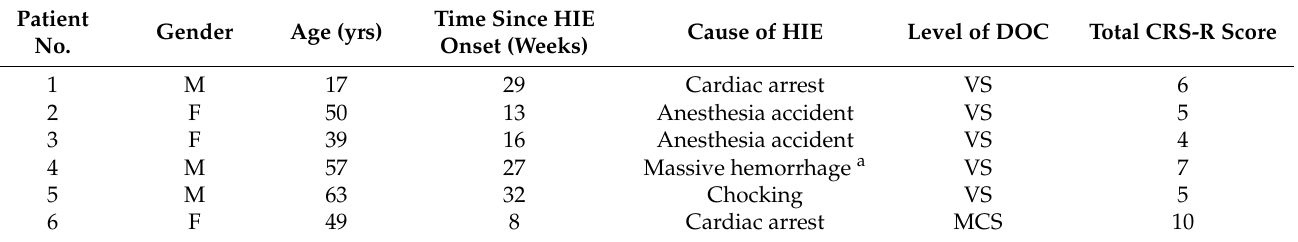
Table 1. Patients with HIE.